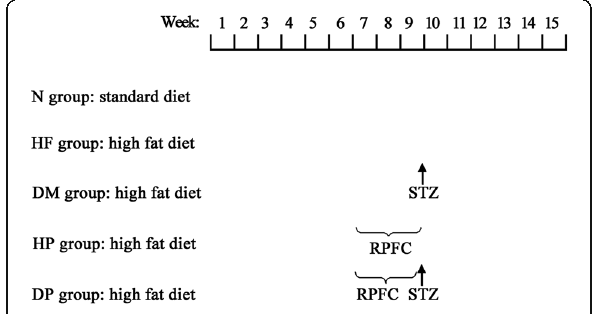
Fig. 1 Schematic of group design during 15